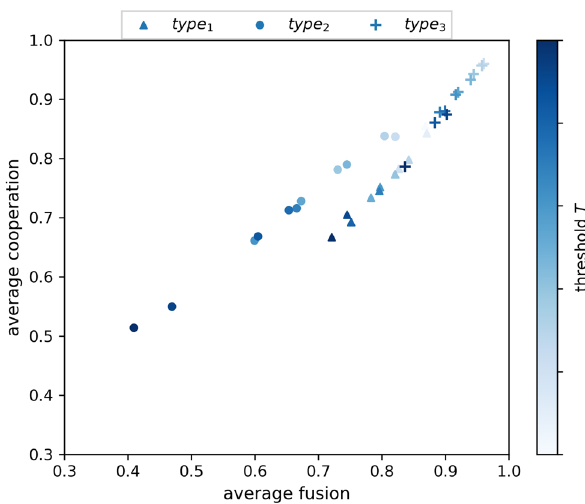
Figure 4. Average cooperation as a function of the average level of fusion for type 1, 2 and 3 ostracism. Ostracism is performed by each agent i with a probability equal to the agent’s fusion level f i . Each data point is referenced by different probabilities of a threshold T defined as the minimum threshold that an agent’s fusion must reach in order for ostracism to take place ( f i ≥ T ). T is defined as a threshold value within the range [0,1] fixed for each of the agents. Agents interact randomly with the other fused individuals within their in-group with a probability equal to their own fusion levels ( S i = f i ). The in-group of an agent i is defined as the subset of agents having at least same level of fusion as i (i.e., f i or greater). Agents interact randomly with the whole population with a probability equal to 1 − S i . Results are averaged over five randomly seeded runs, each conducted for 50,000 generations. Parameter settings are consistent with Fig.